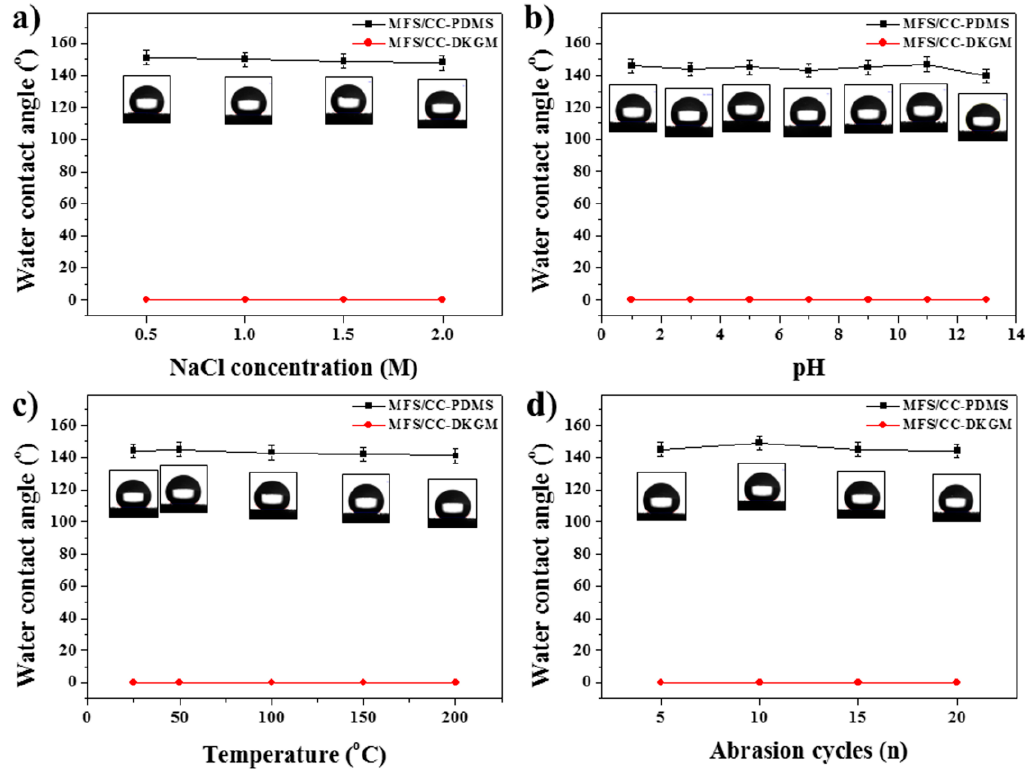
Figure 6. WCA data for the MFS/CC-DKGM and MFS/CC-PDMS under various stimuli: a ) salt, b ) pH, c ) heat, and d ) mechanical abrasion treatments.